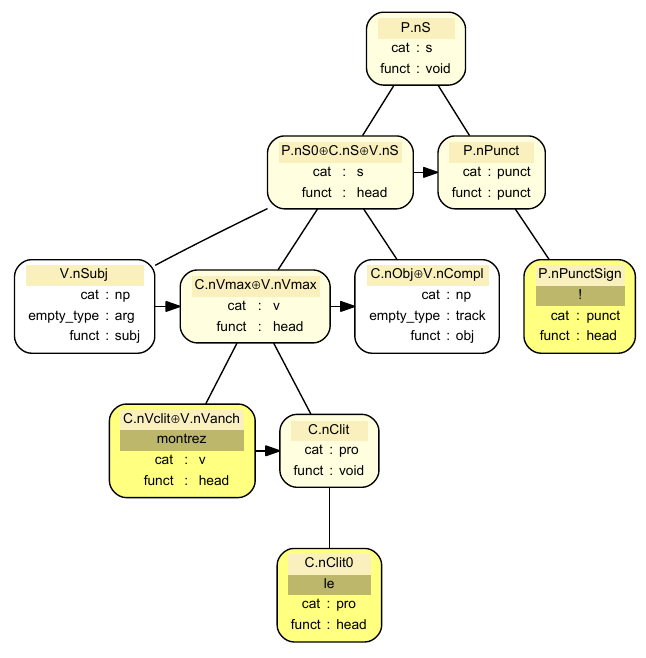
Figure 3: Tree model of the PTD shown in Figure 2 representing the syntax of the sentence